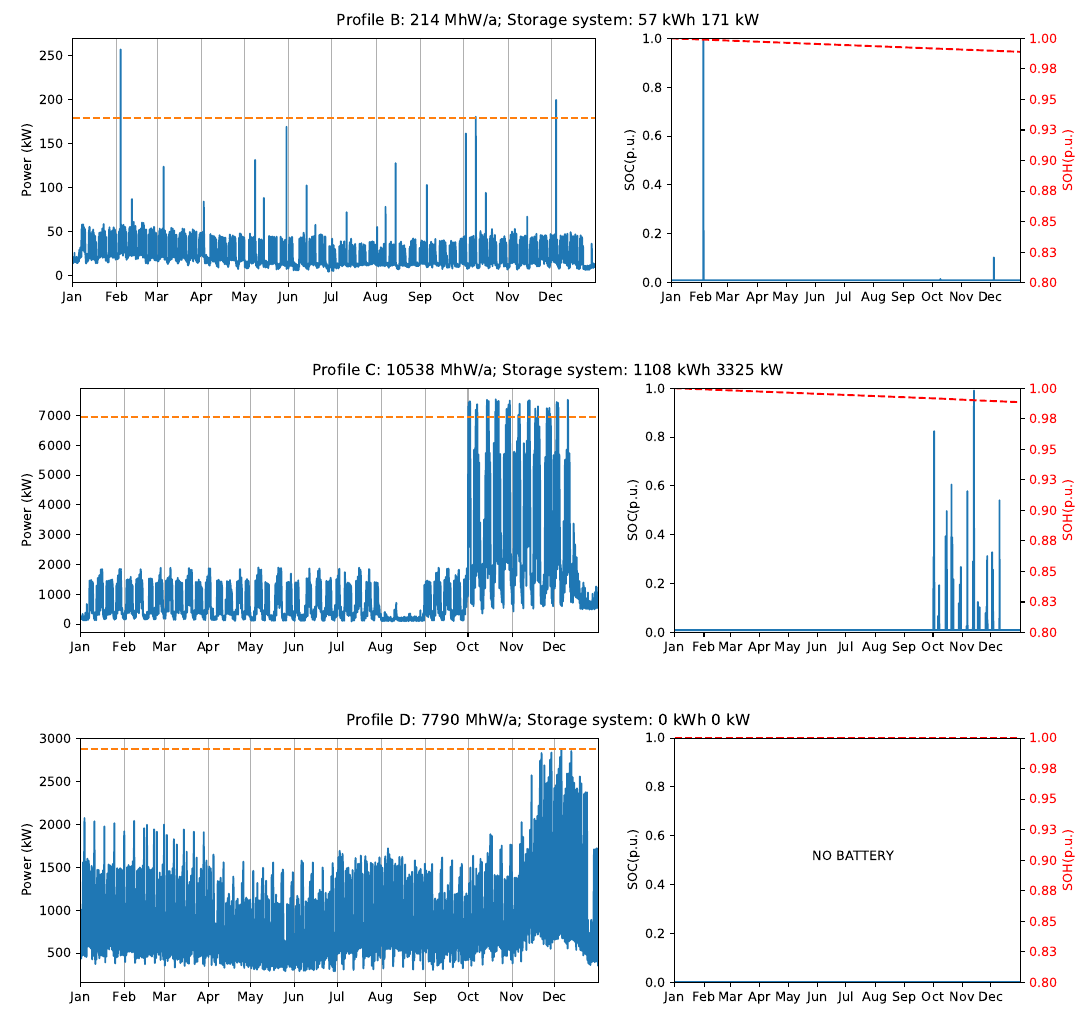
Figure 11. Industrial load profile B,C, and D with yearly billing scheme ( left ), and battery state of charge and state of health ( right ).